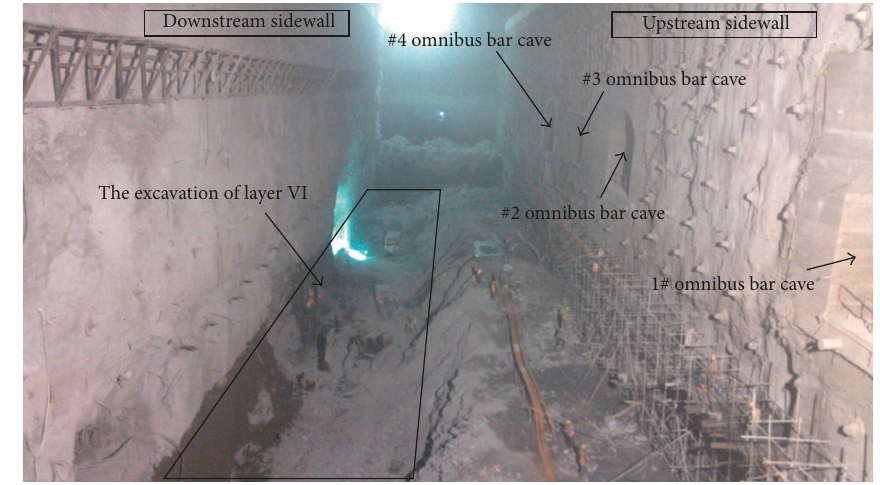
Figure 5: The excavation of layer VI (the photo was taken on December 21, 2013).